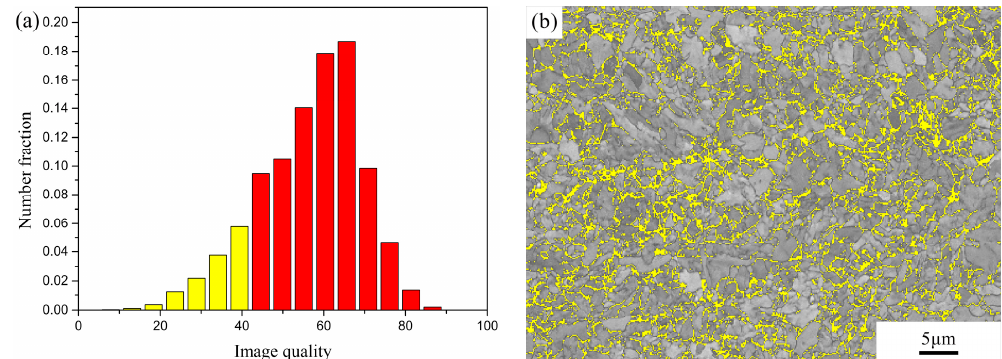
Figure 8. Fusion zone in the heat-treated joint (P = 2500 W, t = 5 ms): ( a ) Image quality in percentage showing highlighted low image quality and ( b ) Image quality map showing highlighted phases corresponding to martensite.